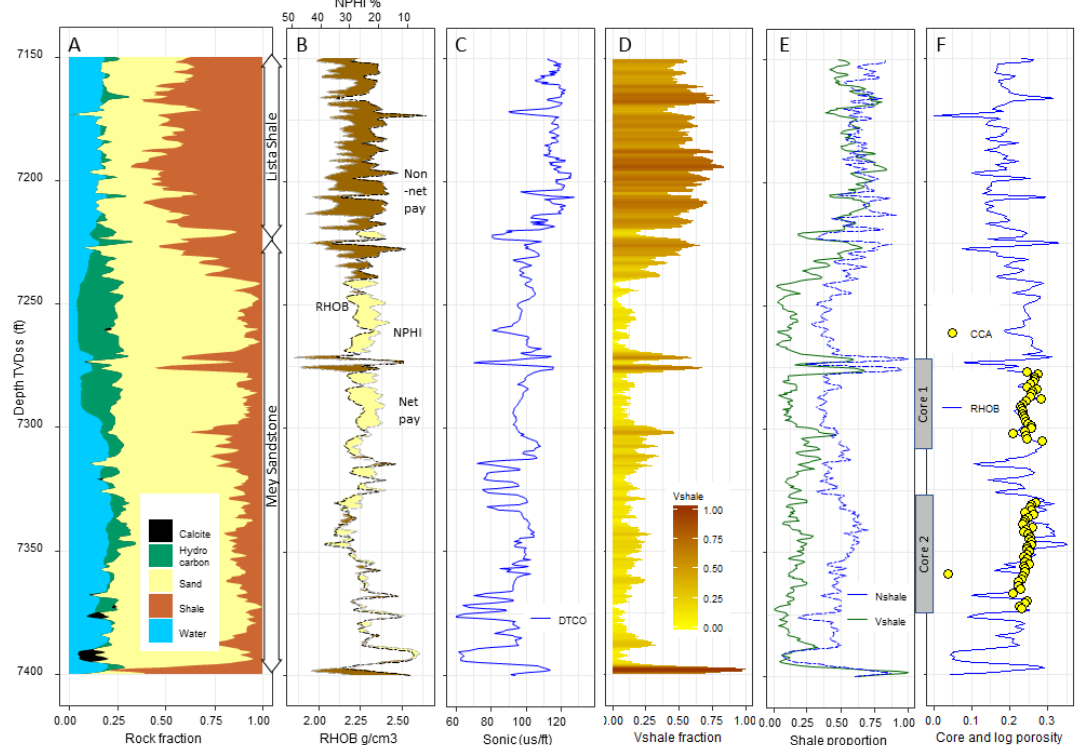
Figure 7. Wireline log raw and interpreted data from well 16/21-20 from the Palaeocene East Mey Storage Site. ( A ) Interpreted lithology and fluid saturation diagram showing the Mey Sandstone and Lista Shale top-seal. The most shaley part of the Lista was not cored in this well. ( B ) Neutron-density